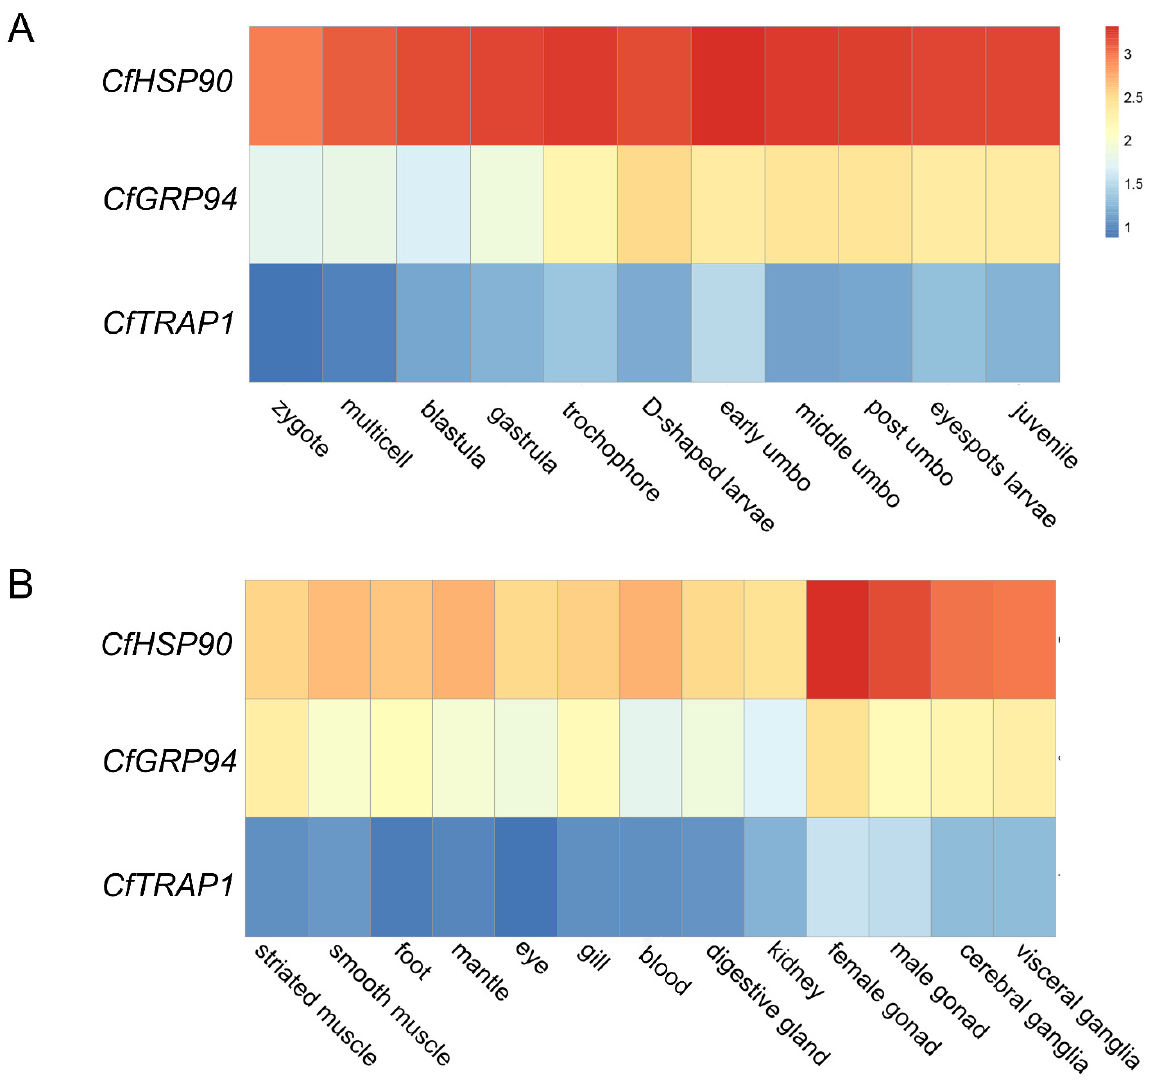
Figure 4. Expression analysis of CfHSP90 , CfGRP94 , and CfTRAP1 at different developmental stages ( A ) and in adult tissues ( B ) of C. farreri based on the log 10 RPKM value.